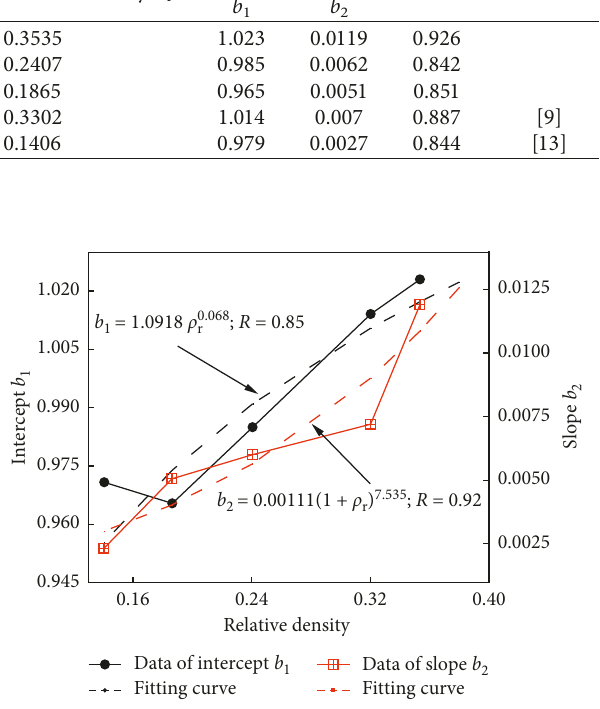
Figure 7: The relationship of coefficients and relative density of honeycomb.